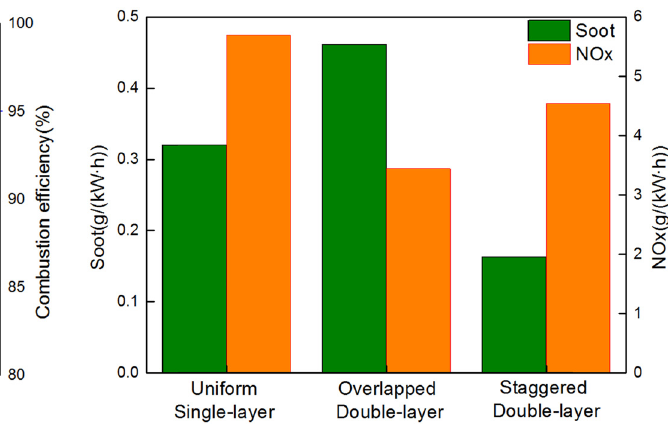
Figure 22: Speci fi c power and combustion e ffi ciency for di ff erent arrangements of nozzle